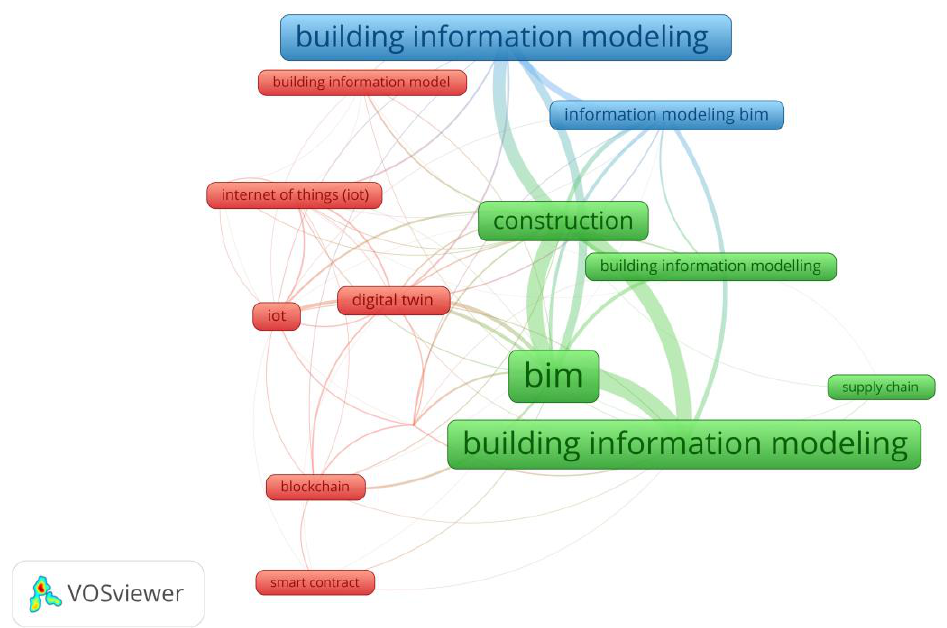
Figure 14. Network visualization of the keyword co-occurrence of Blockchain and Smart contract in BIM, IoT, and DT.